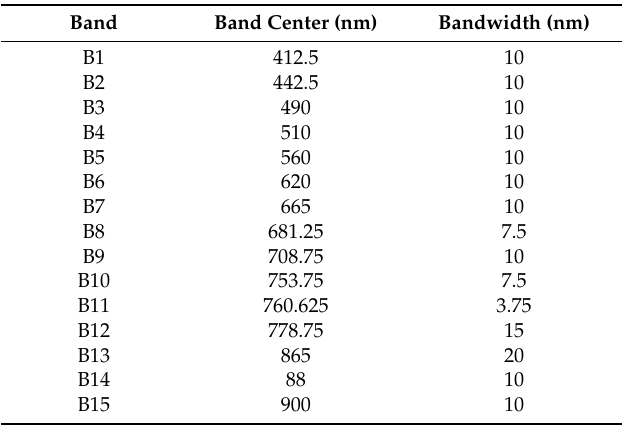
Table 2. Band centers and bandwidths of the Medium Resolution Imaging Spectrometer (MERIS).